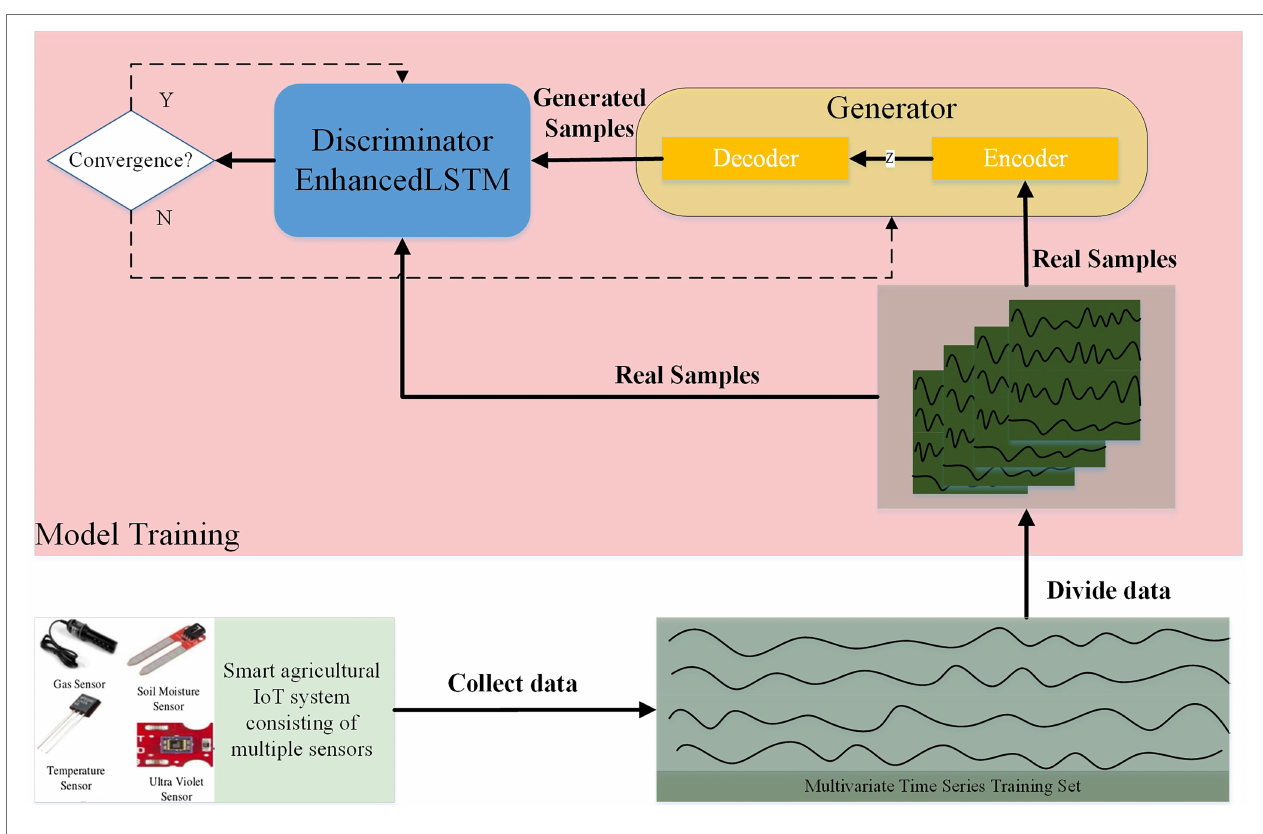
FIGURE 2 | Overall framework of